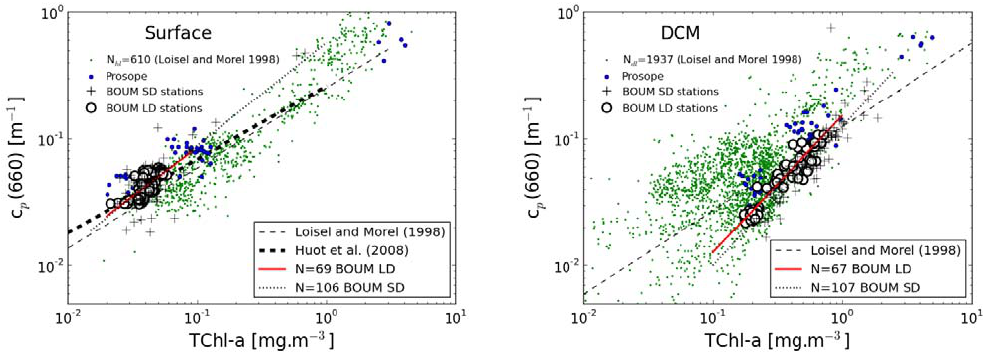
Fig. 6. Variations of the particulate attenuation coefficient, c p (660), as a function of the TChl- a concentration for (a) the surface layer, and (b) at the DCM. The data collected during BOUM at the LD and SD stations, during the PROSOPE cruise, and those gathered by Loisel and Morel (1998) are plotted as indicated. N hl and N dl represent the number of data available in the Loisel and Morel (1998)‘s data set for the homogeneous and the deep layers, respectively. The results of the present and previous regression analyses are also plotted as